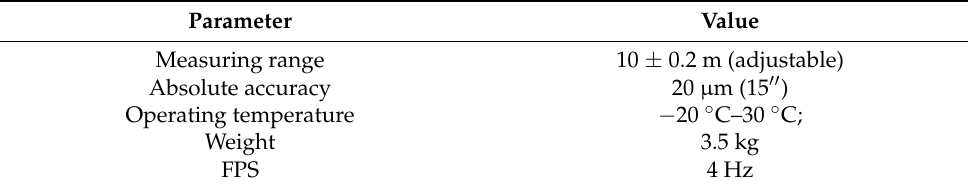
Table 2. Prototype parameters of the proposed multi-sensor fusion-based 6-DOF pose measurement system.